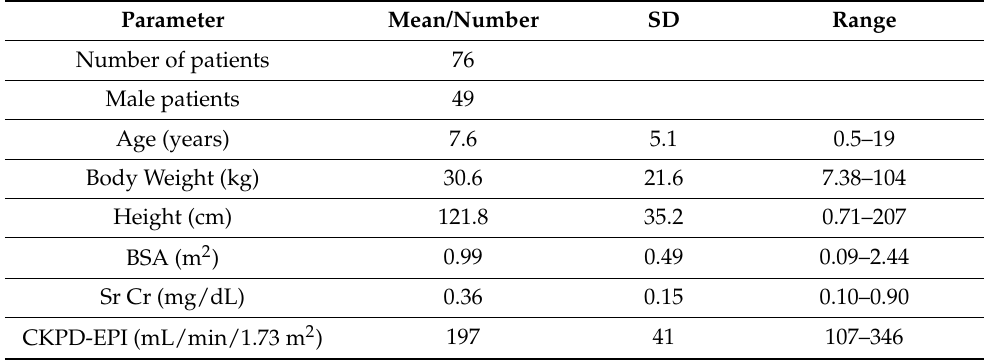
Table 1. Demographic characteristics of the patients.